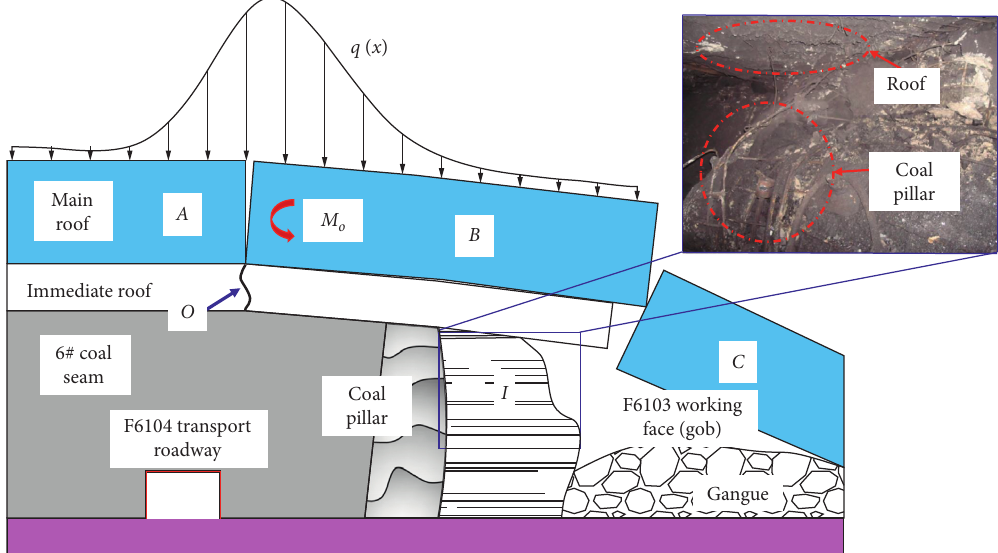
Figure 4: Fracture mode of roadway roof after coal mining.